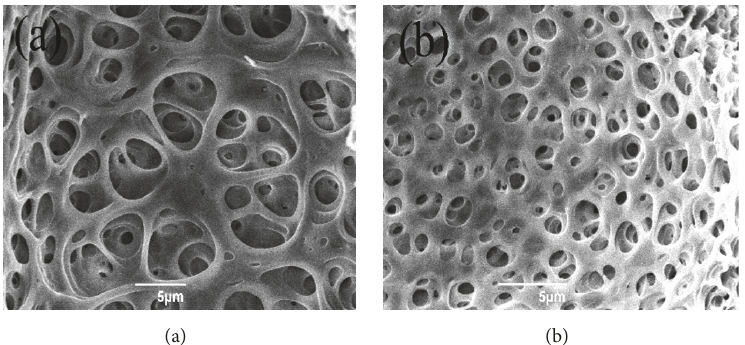
Figure 9: SEM images of PES/C0.1 (a) and PES/N0.1 (b) in detail.